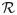
Weighted histograms of η1, 1 − η0, βU, and R (from left to right) based on stochastic variation of η1, 1 − η0, and βU.Each sample contributes with its Akaike weight, which is based on a fit to the data from February 28 to March 11, 2020, to the histogram (see Eq (4)). Dark blue bins lie within the 95% confidence interval, light blue bins lie outside. Apparently, η1 cannot be well identified using these data. The red bin indicates the mean value (of 1 − η0 = 0.74 (0.59–0.92), of βU = 1.63 (1.39–1.88), and of R=6.95 (5.76–8.25)).